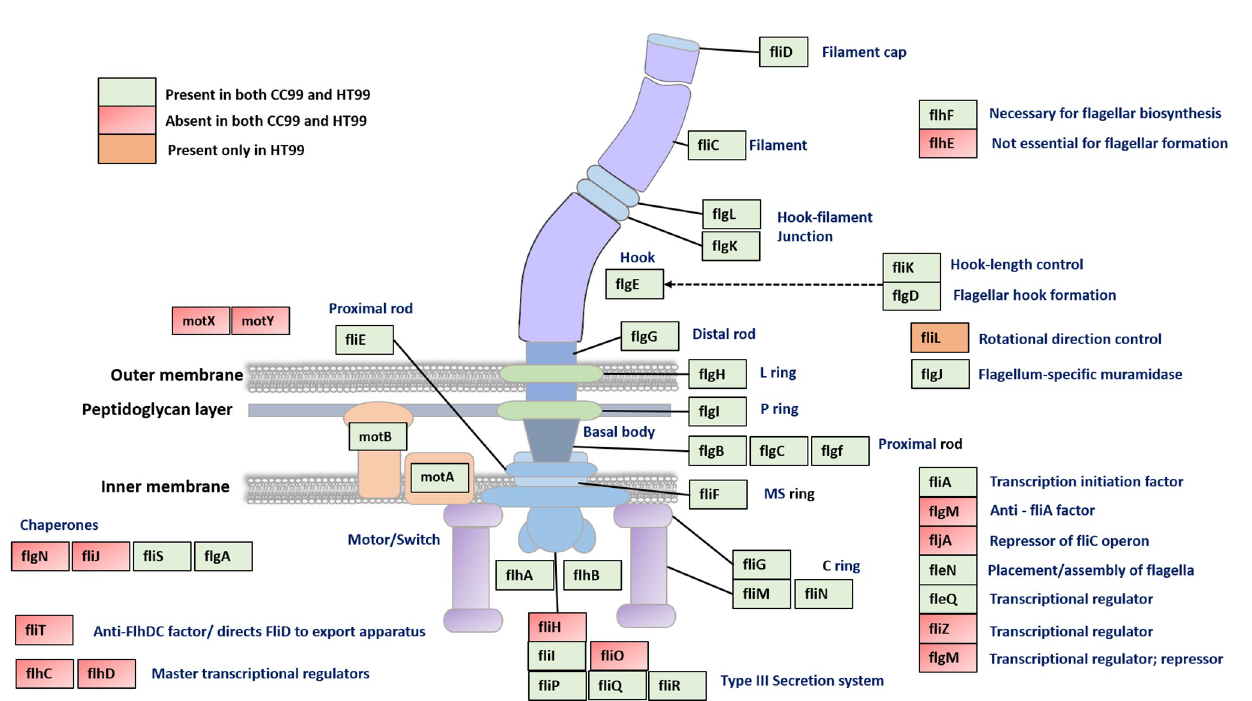
Fig 5. Genes involved in the synthesis of flagella in bacteria. Gene homologs encoding flagellar proteins identified in “ Ca . B. cookevillensis” (CC99) and “ Ca . B. aquae” (HT99). Genes encoding motor/switch, basal body, hook, filament, filament cap proteins were identified.